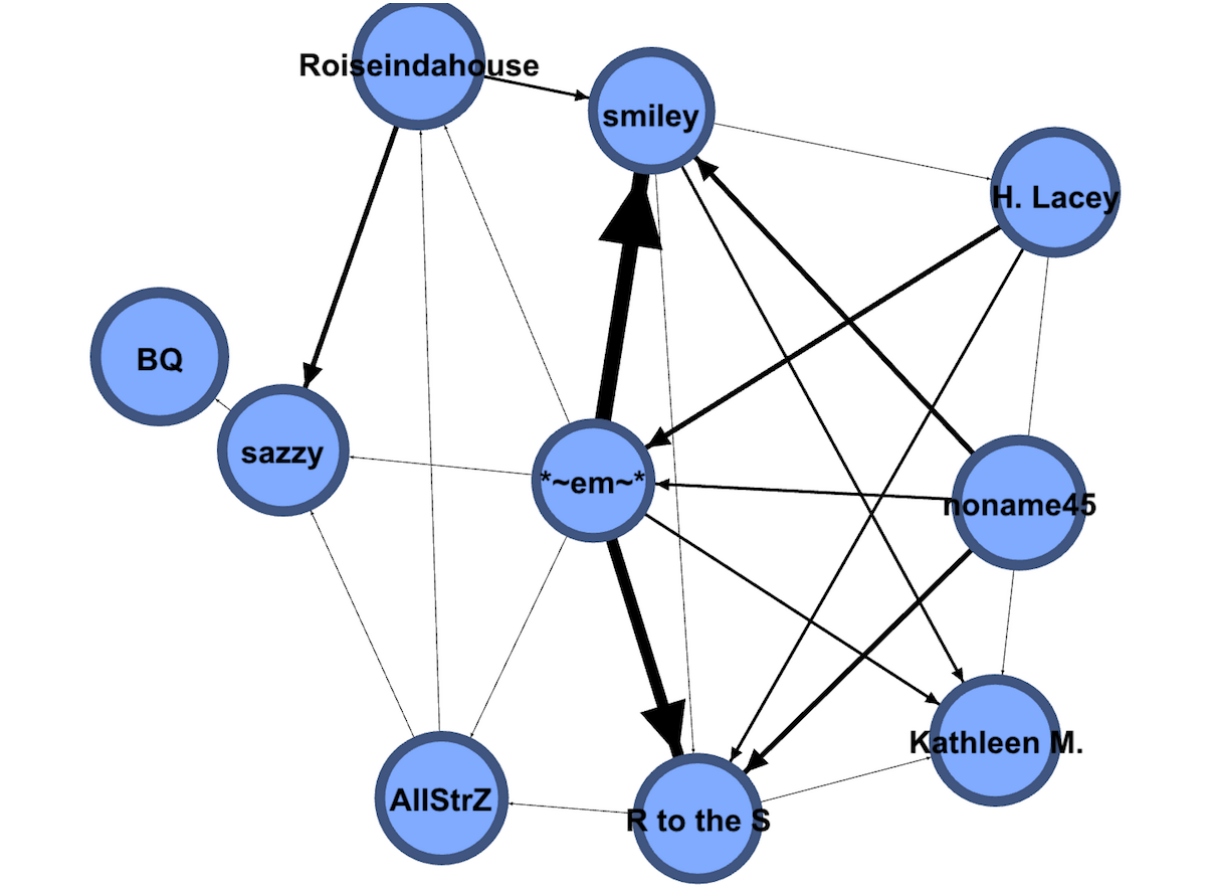
Figure 7. The social network of users with high-degree nodes (degree